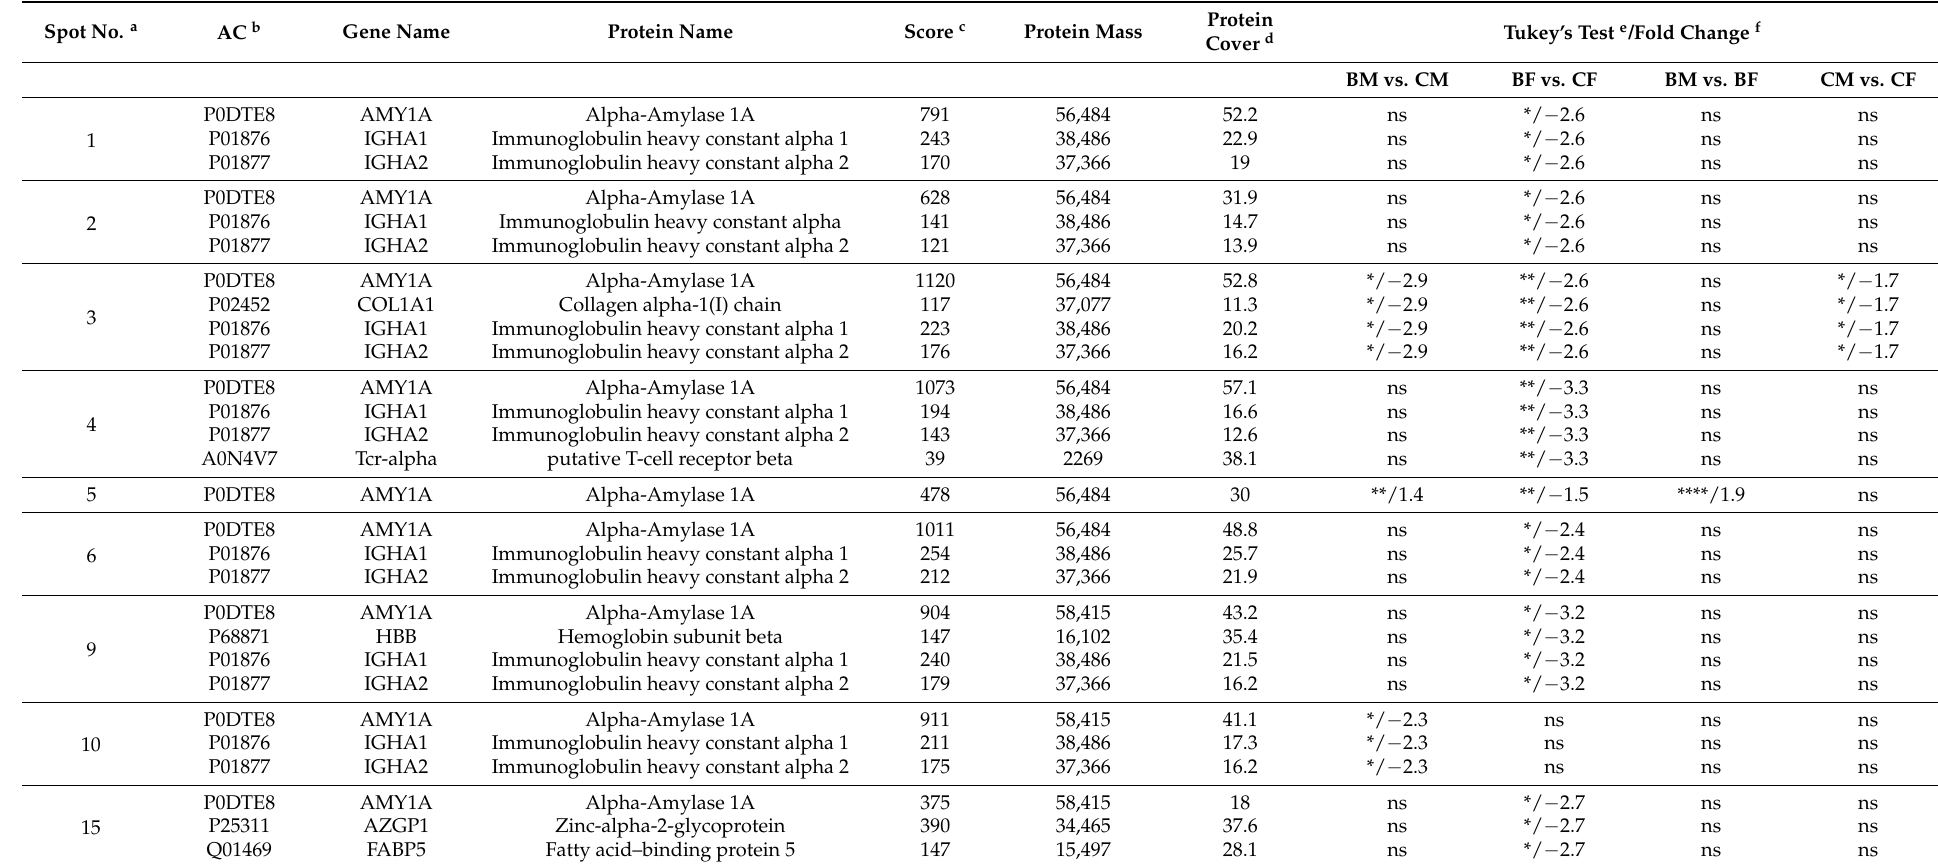
Table 2. Differentially expressed protein spots from 2DGE identified by LC–MS/MS